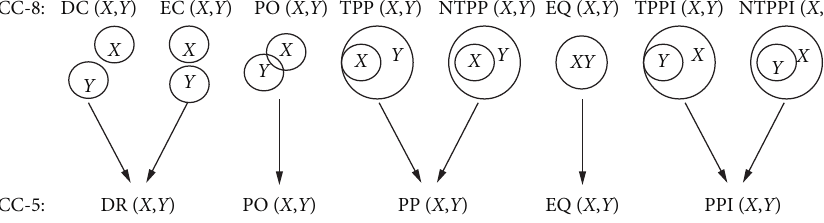
Figure 1: The relationships between RCC-8 and RCC-5 intersection models. Table 1: Matrix representation of the RCC-5